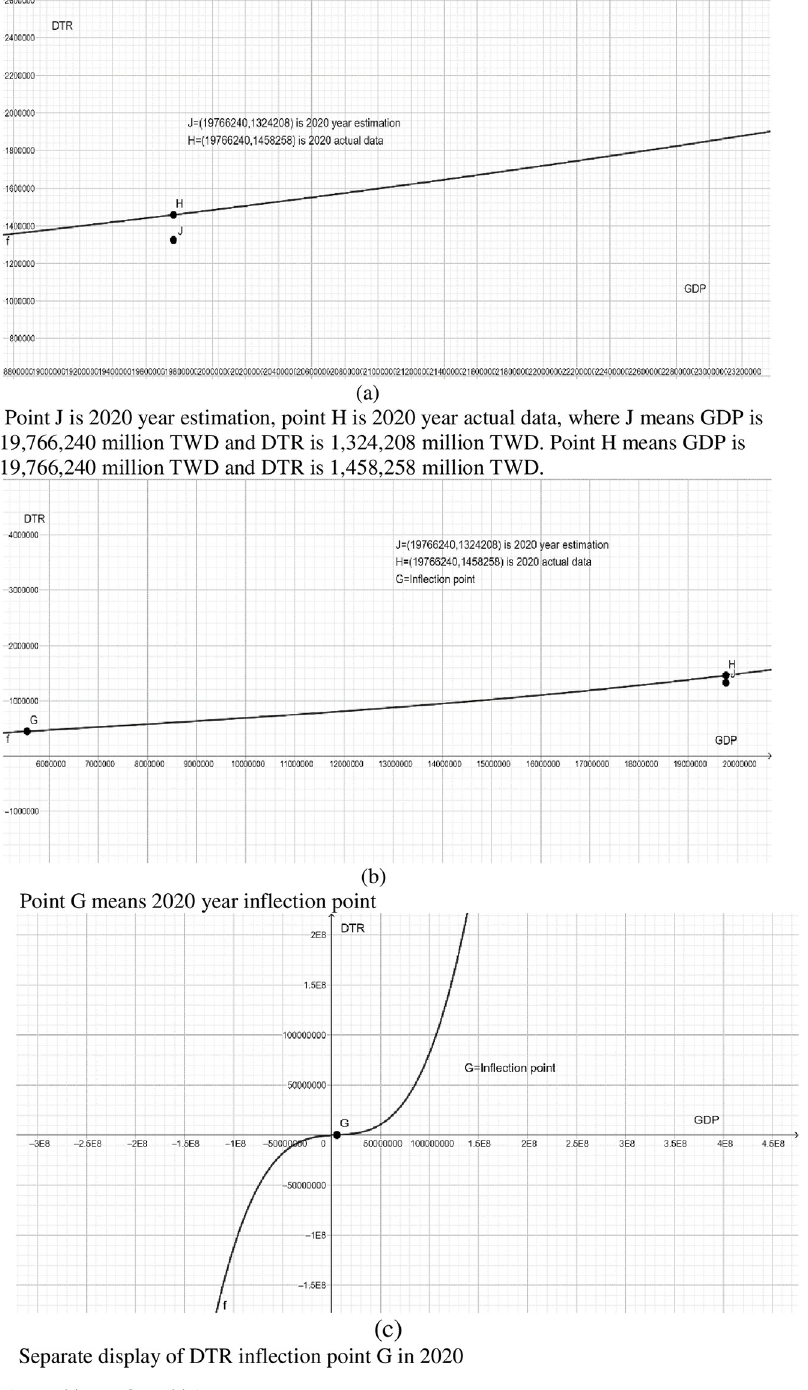
Fig 3. DTR-to-GDP, Taiwan,